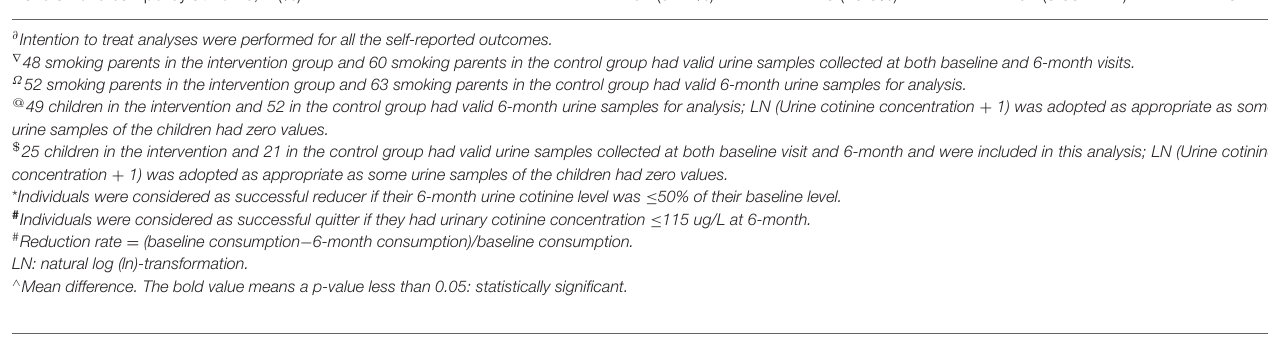
TABLE 4 | Parental self-reported reductions in cigarette consumption and Fagerstrom Test for Nicotine Dependence (FTND) ( N = 210). Parental reduction in cigarette consumption at 1-month (cig/day), median